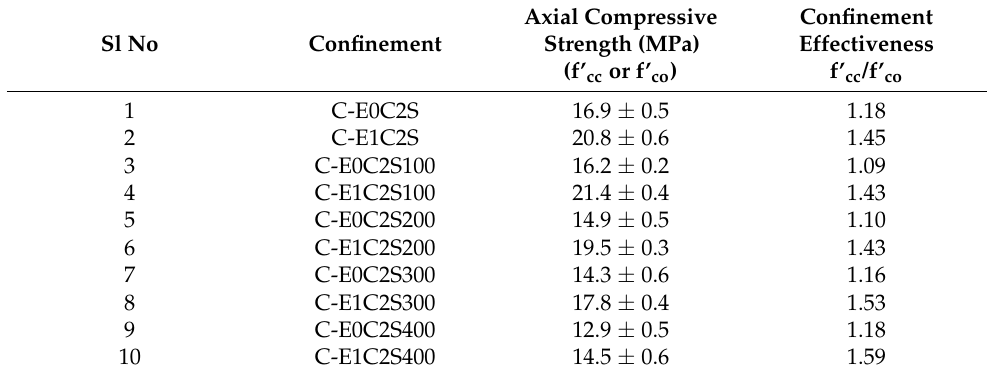
Table 5. Compression test results of SFRP-confined specimens exposed to elevated temperature.